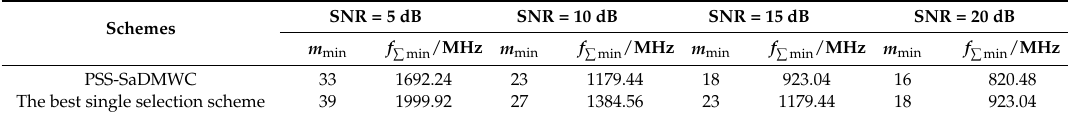
Table 5. The comparison on the minimum number of SUs and minimum sampling rate needed.